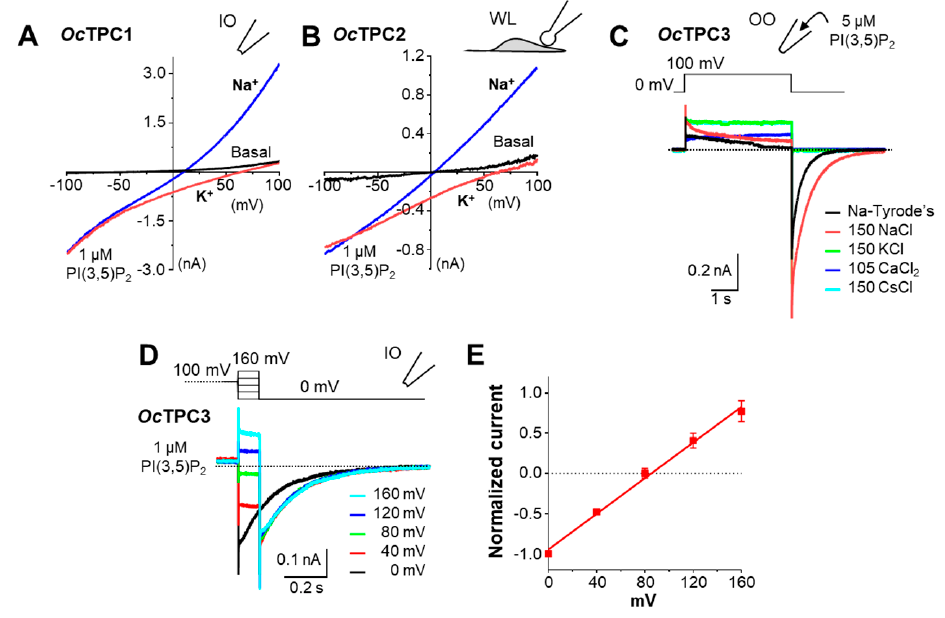
Figure 4. All three TPC subtypes from rabbit are Na + selective when activated by PI(3,5)P 2 . HEK293 cells were transiently transfected with cDNA coding for Oc TPC1-EGFP, Oc TPC2-EGFP, or Oc TPC3-EGFP. ( A , B ) Representative I–V curves derived from voltage ramps for Oc TPC1 in an inside-out (IO) patch ( A ) and Oc TPC2 in a whole-endolysosome (WL) patch ( B ) sequentially exposed to 1 µ M PI(3,5)P 2 in the normal bath solution containing mainly K + ( red traces ) and then in a Na + -based bath solution ( blue traces ). ( C ) Representative current traces of Oc TPC3 detected in an outside-out (OO) patch containing 5 µ M PI(3,5)P 2 in the pipette solution and sequentially exposed to normal Tyrode’s solution followed by equiosmotic solutions that contained 150 mM NaCl, 150 mM KCl, 105 mM CaCl 2 , and 150 mM CsCl. Note the lake of tail currents in KCl, CaCl 2 , and CsCl. ( D ) Representative current traces of Oc TPC3 detected in an IO patch exposed to 1 µ M PI(3,5)P 2 in normal Tyrode’s solution. After stepping to +100 mV for 4 s, the voltage was switched to 0, 40, 80, 120, and 160 mV for 100 ms before returning to 0 mV. For clarity, only the last 0.1 s of the +100-mV step is shown together with the tail currents at post-step potentials of 0 to 160 mV followed by that at 0 mV. For ( C , D ), dashed lines indicate zero current. ( E ) I–V relationship of currents at the post-step potentials normalized to that of the absolute value at 0 mV for patches recorded as in ( D ). Data points are means ± SEM of n = 5 patches fit by linear regression.